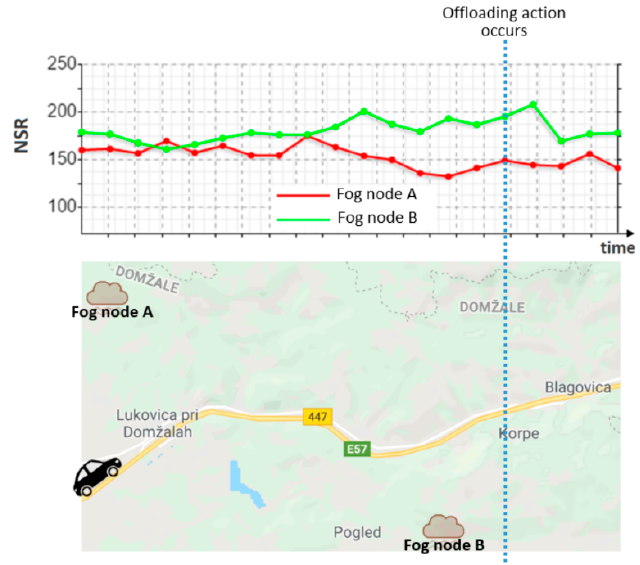
Figure 9. NSR values offered by two Fog nodes in a specific part of the trip.